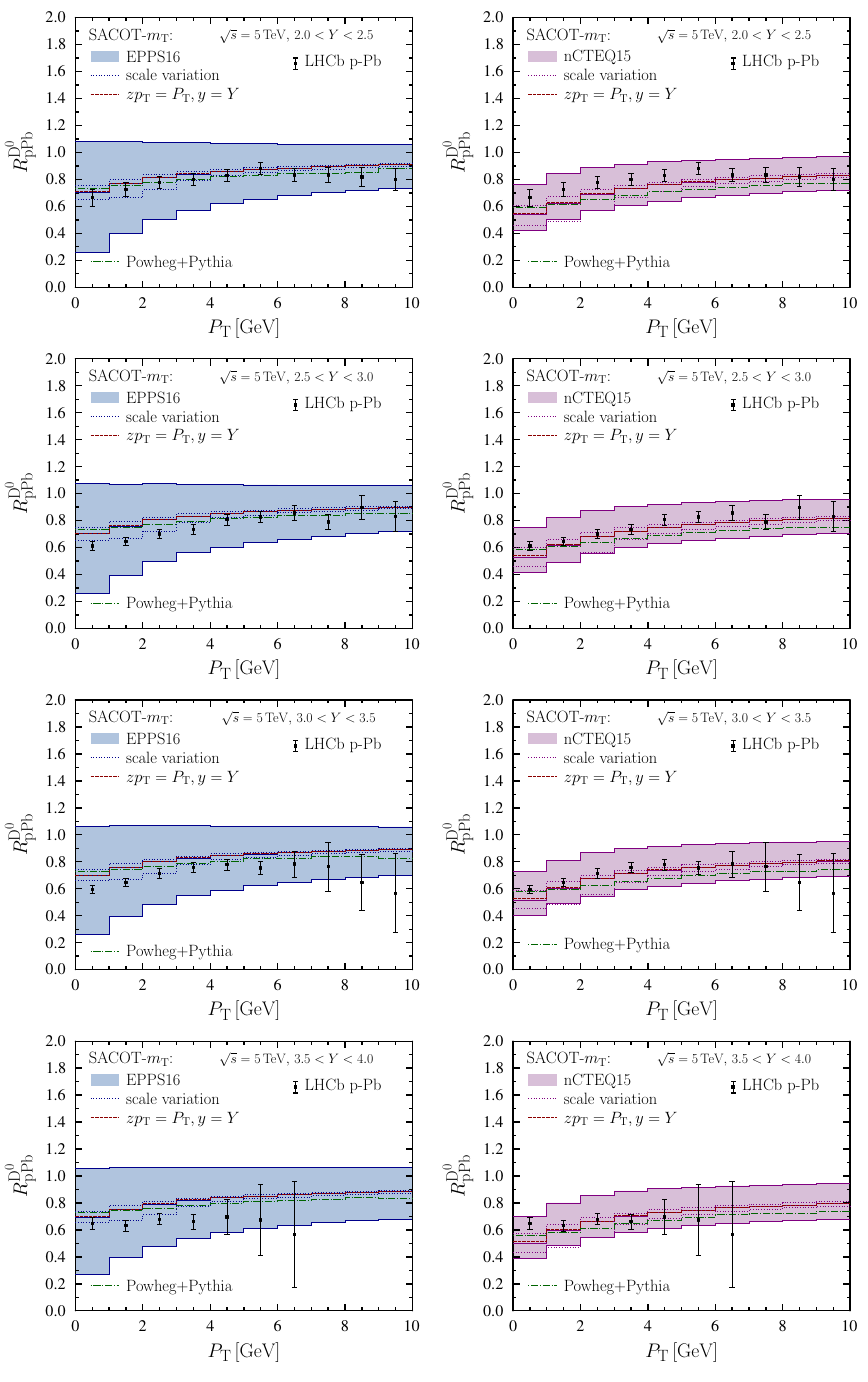
Figure 4 . Same as (cid:12)gure 3 but at forward